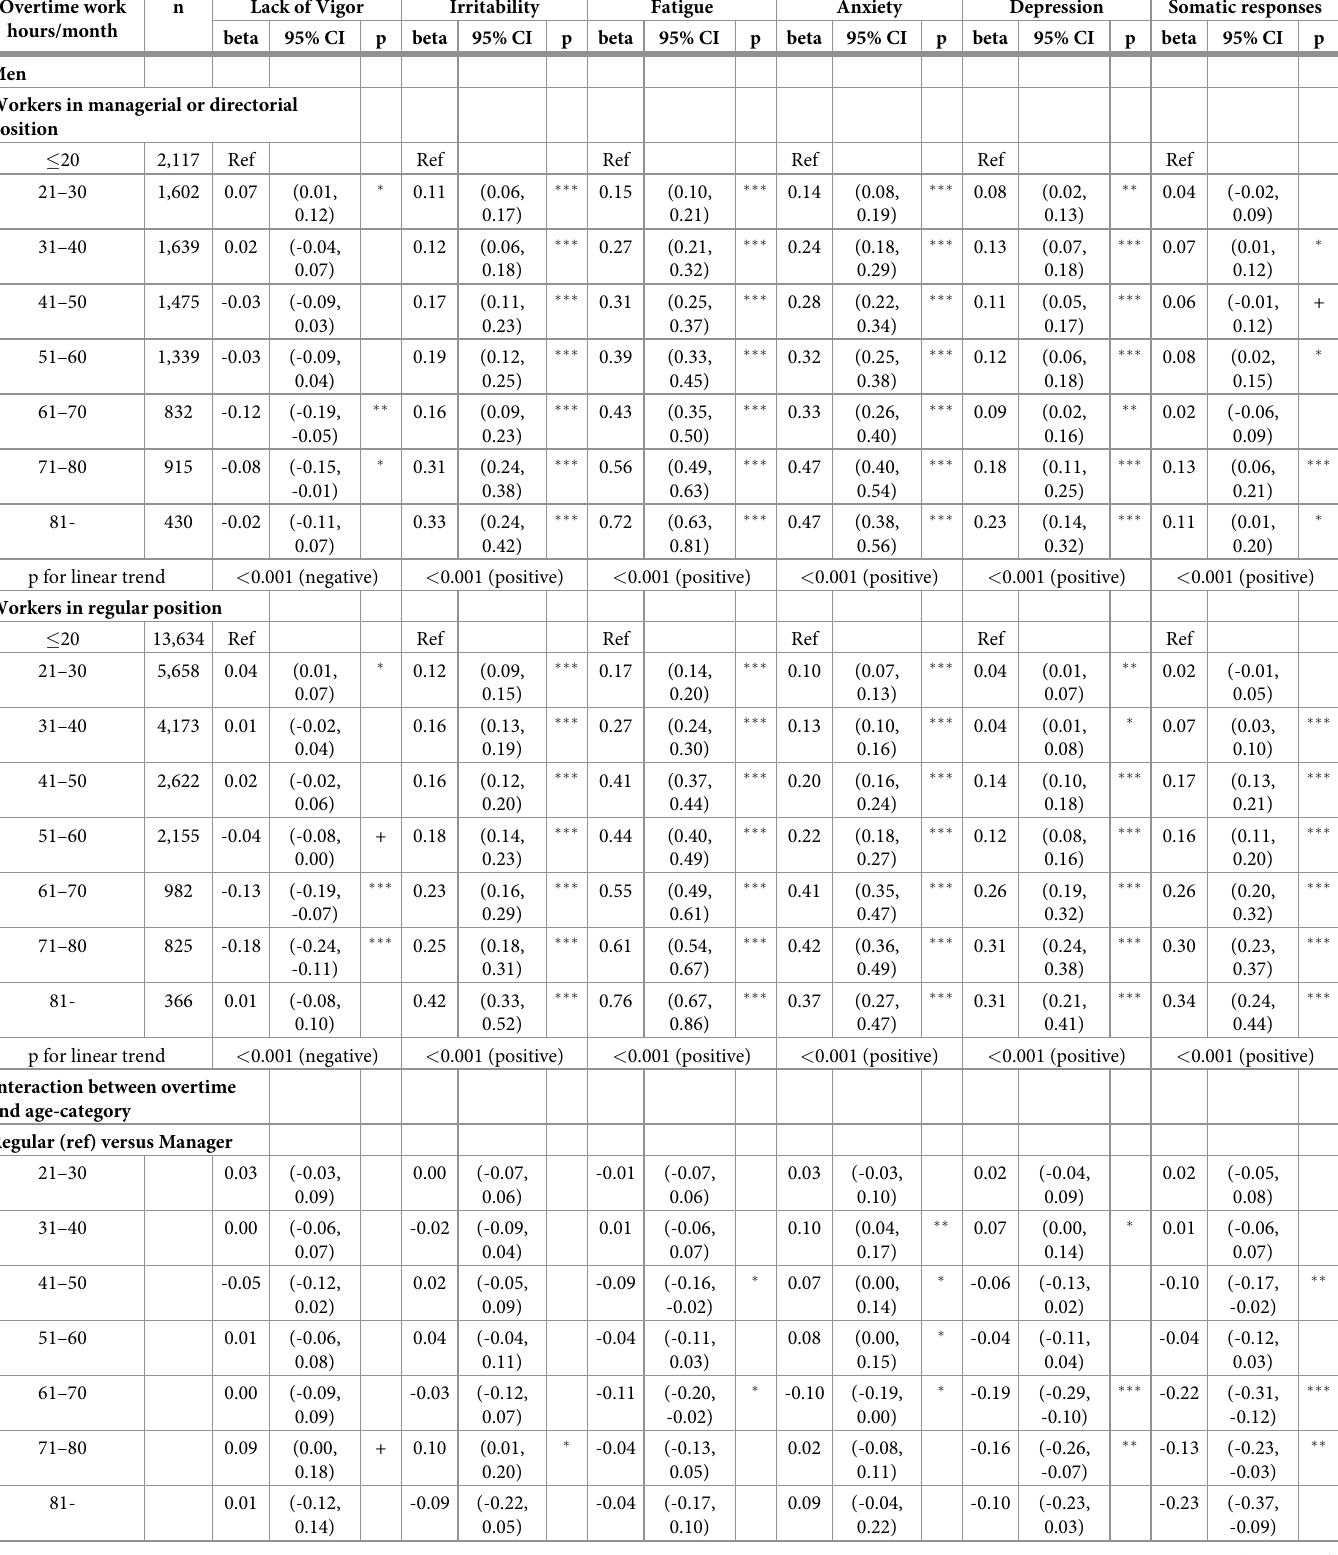
Table 4. Association between overtime work hours and stress responses: Results of multiple linear regression stratified by gender and job-class. Overtime work